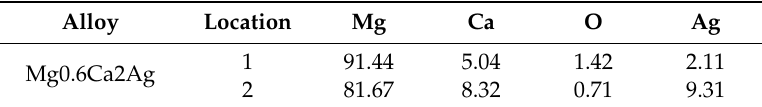
Table 5. EDS analysis (at.%) of the Mg0.6Ca2Ag alloy at the locations of SKPFM mapping as per Figure 5.